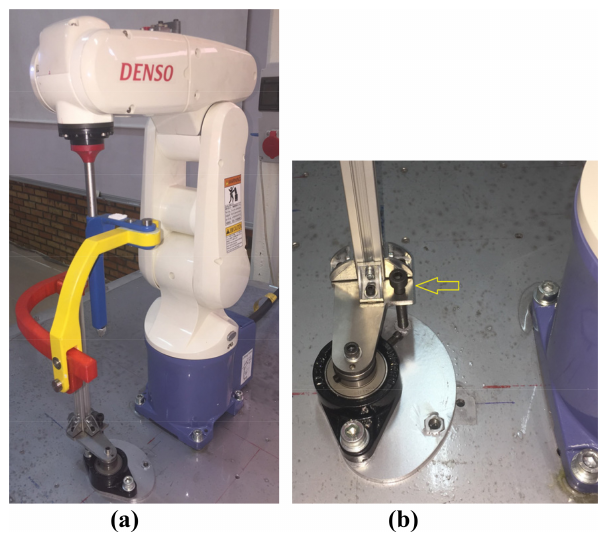
Figure 10. AA configuration and rotatable system.